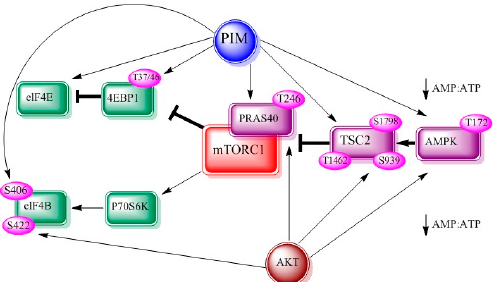
Figure 3. Interrelationship between PIM, AKT and mTOR adapted from figure 2 of [8]. AMP-dependent kinase (AMPK), eukaryotic translation initiation factor 4E (eIF-4E), eukaryotic translation initiation factor 4B (eIF-4B). PIM kinases expression supports survival of chronic lymphocytic leukemia cells and promotes the CXCR4-mTOR dependent migration [44]. Similarly, mTOR pathway modulation and AZD1208 cytostatic effects are also identified by protein profiling [45]. mTOR regulation by PIM kinases and their interrelation in other cancers advocate their magnitude in tumorigenesis.